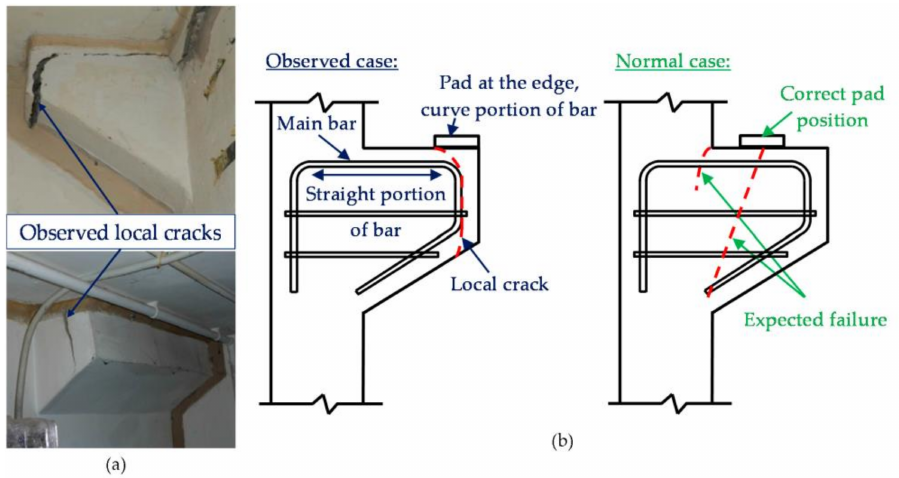
Figure 1. ( a ) Field observed premature corbel failure case; ( b ) failure pattern